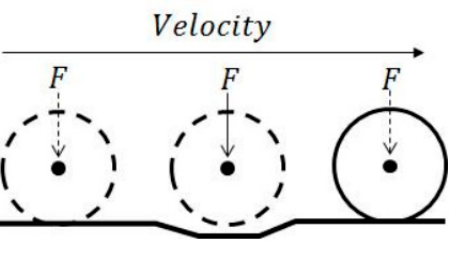
Figure 1. Wheel floating above the rail.